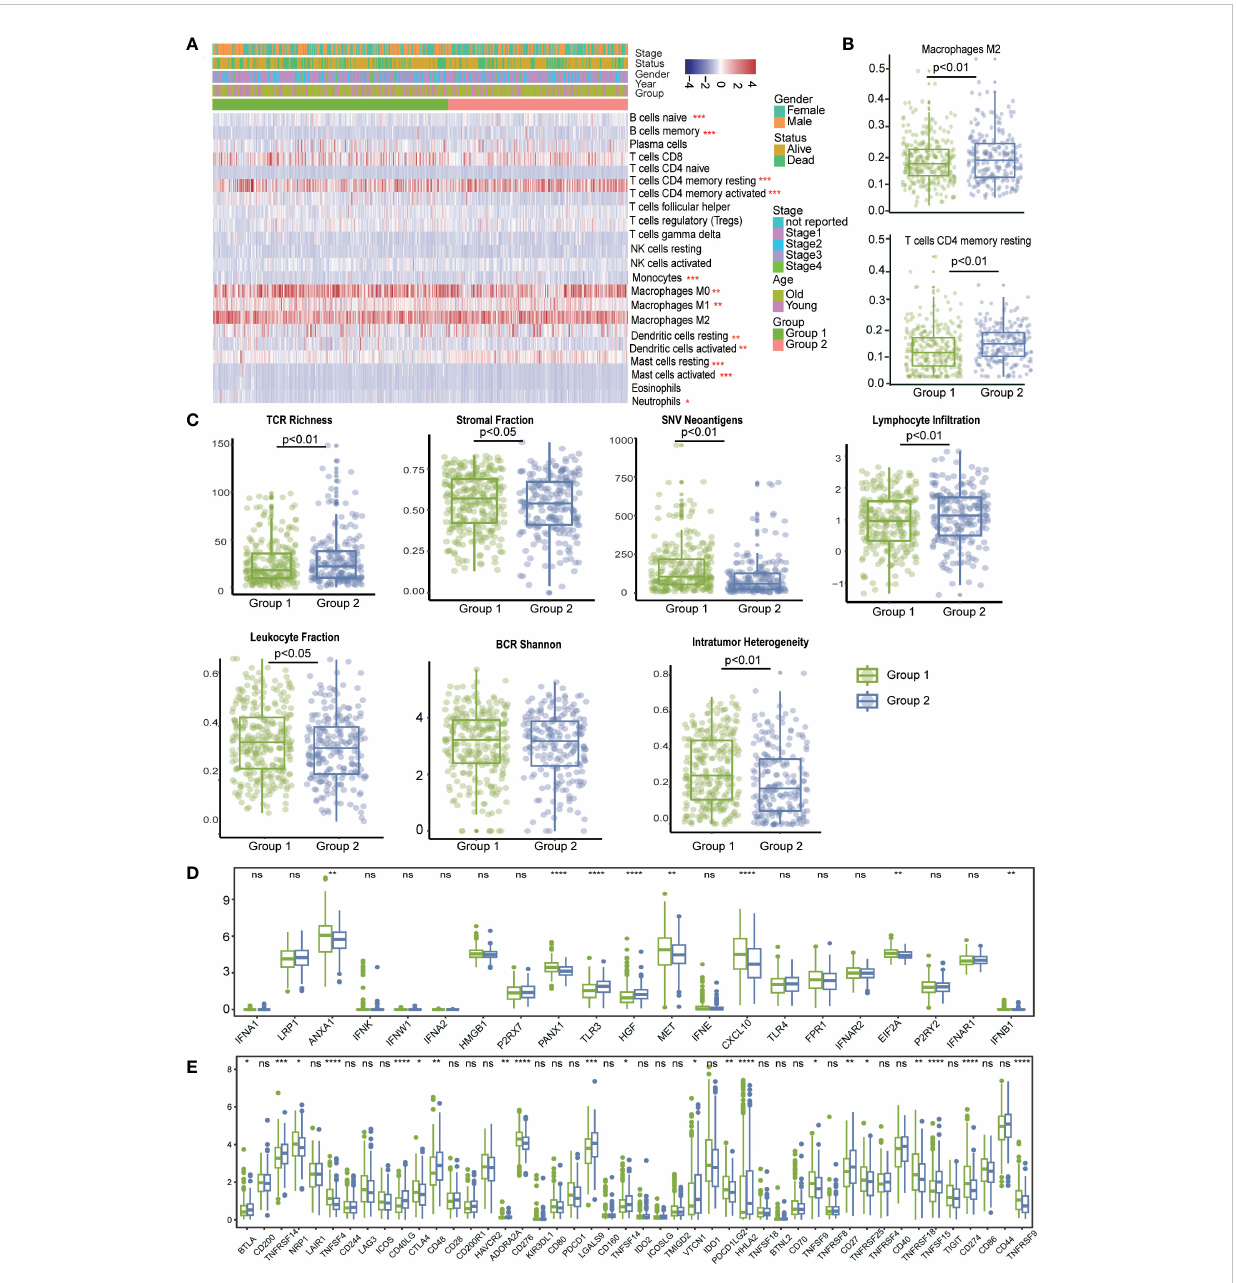
FIGURE 6 The immune landscape in distinct LRI-related molecular patterns in LUAD. (A) “ CIBERSORT ” analysis identifying the relative in fi ltration level of immune cell populations in two LRI subgroups of LUAD samples in the TCGA cohort. (B) Differences in regulatory T-cell and MDSC proportions among distinct LRI subgroups in TCGA cohorts. (C) The relative distributions of the leukocyte fraction, stromal fraction, SNV neoantigens, indel neoantigens, TCR Shannon, BCR Shannon, and ITH scores were compared among the two LRI clusters. (D, E) Association between immune subgroupsand ICPs and ICD modulators. a, b; Differential expression of ICP genes among the two LUAD subgroups. ns p ≥ 0.05; *p < 0.05; **p < 0.01; ***p < 0.001; ****p <